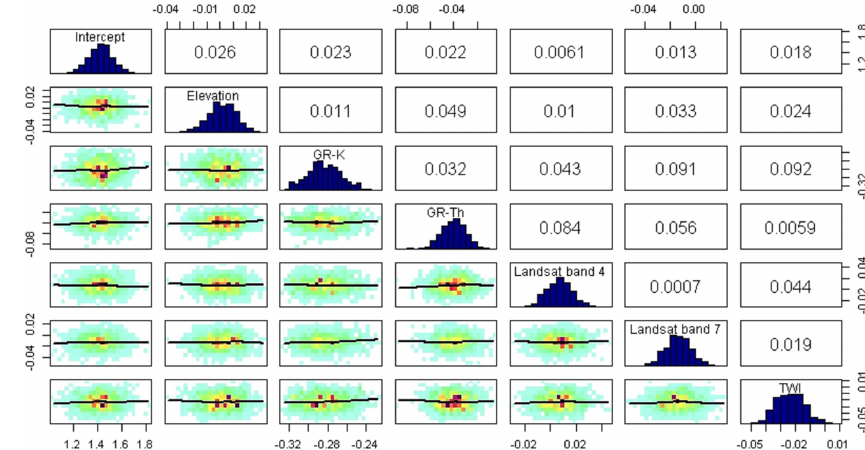
Figure 4. Correlations and posterior distributions of linear trend parameters of the spatial model. Table 1. 1. Posterior parameters of the linear trend model. β 0 β 1 β 2 β 3 β 4 β 5 β 6 Lower CI limit 1.360 − 0.003 0.002 1.416